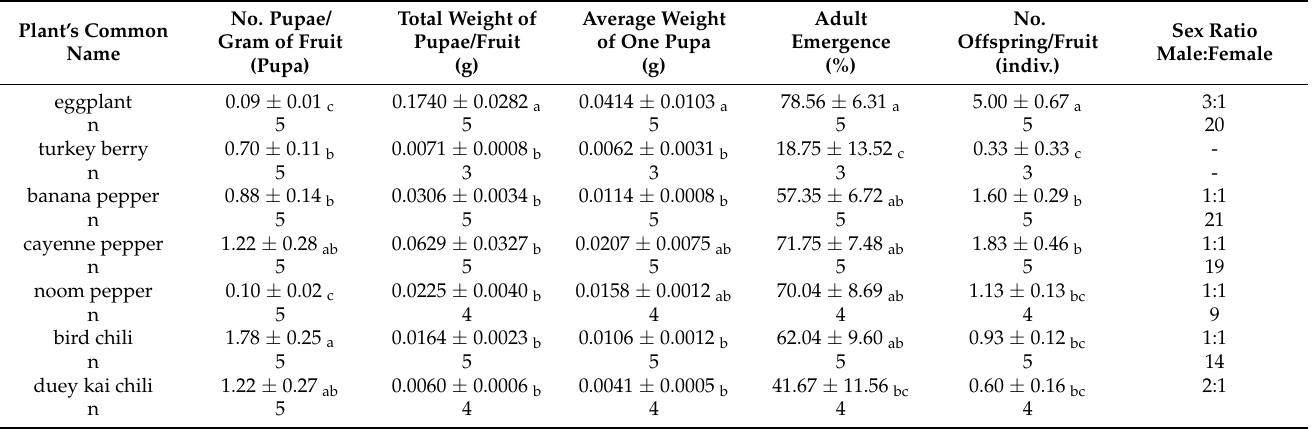
Table 1. The mean number and weight ( ± SE) of pupae and adults of Bactrocera latifrons in the unripe fruit with no-choice experiment. Plant’s Common Name